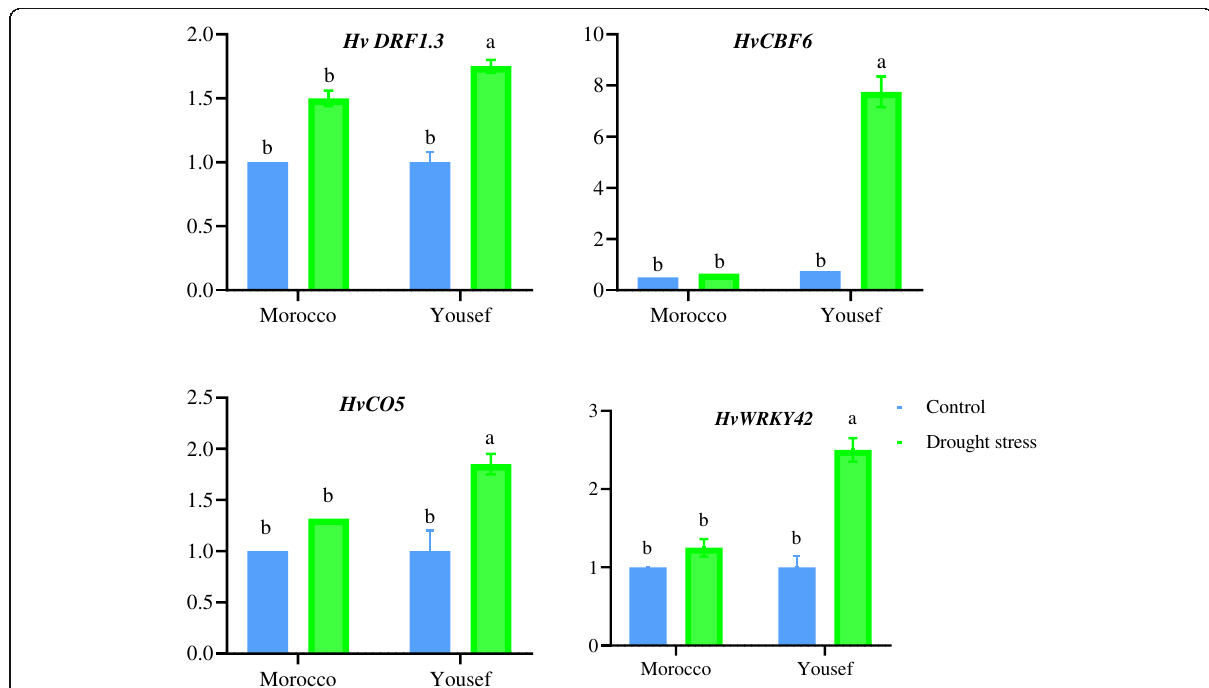
Fig. 7 The expression pattern of four promising candidate genes ( HvDRFI.3 , HvCBF6 , HvCO5 , and HvWRKY 42) under drought conditions in H. vulgare (Yousef, the tolerant, and Moroco, the sensitive